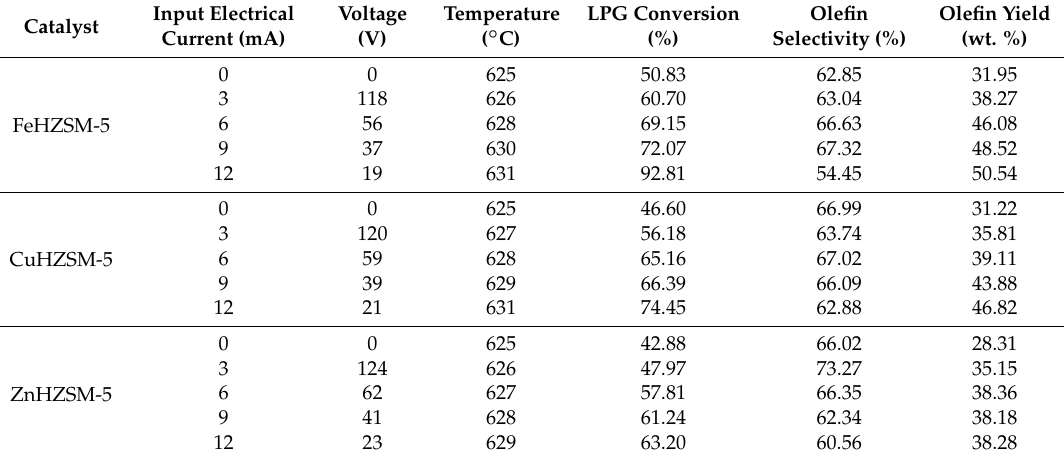
Table 4. Effect of the input electrical current on yield, conversion and selectivity of oxidative dehydrogenation with an external electric field for FeHZSM-5, CuHZSM-5 and ZnHZSM-5 catalysts: